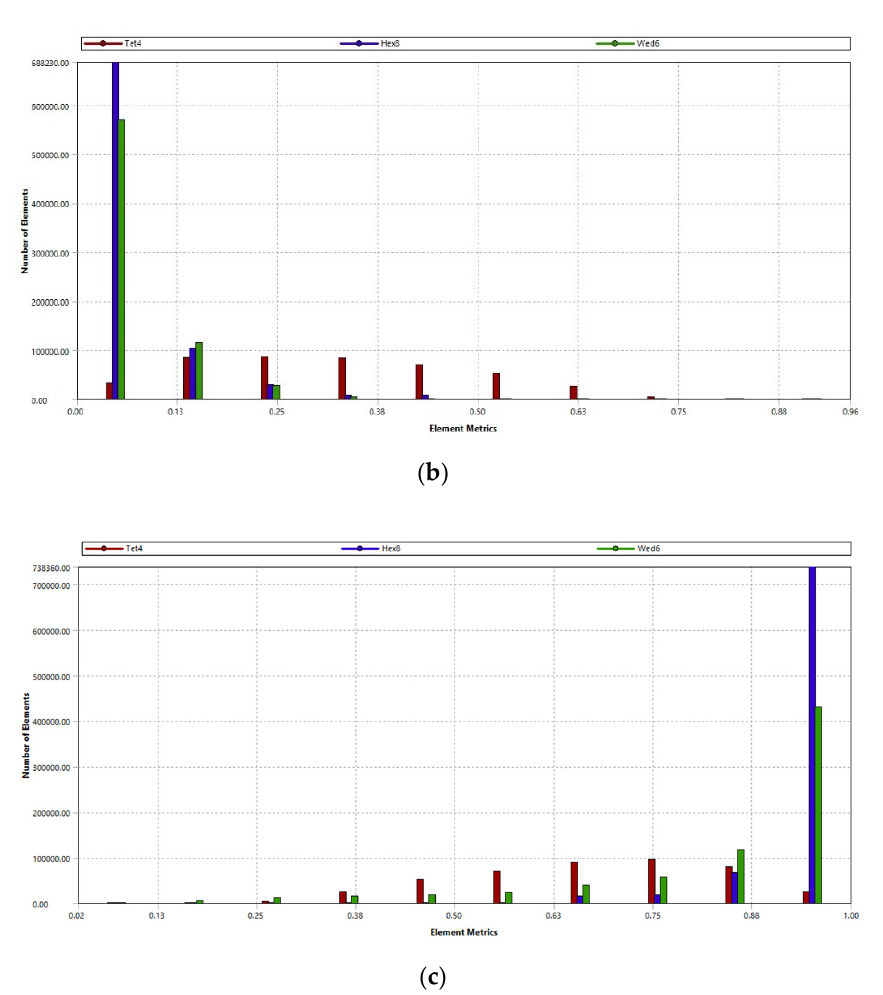
Figure 7. Mesh of the CPVT model: ( a ) side view and isometric view of the meshed model; ( b ) the skewness; ( c ) orthogonal quality.